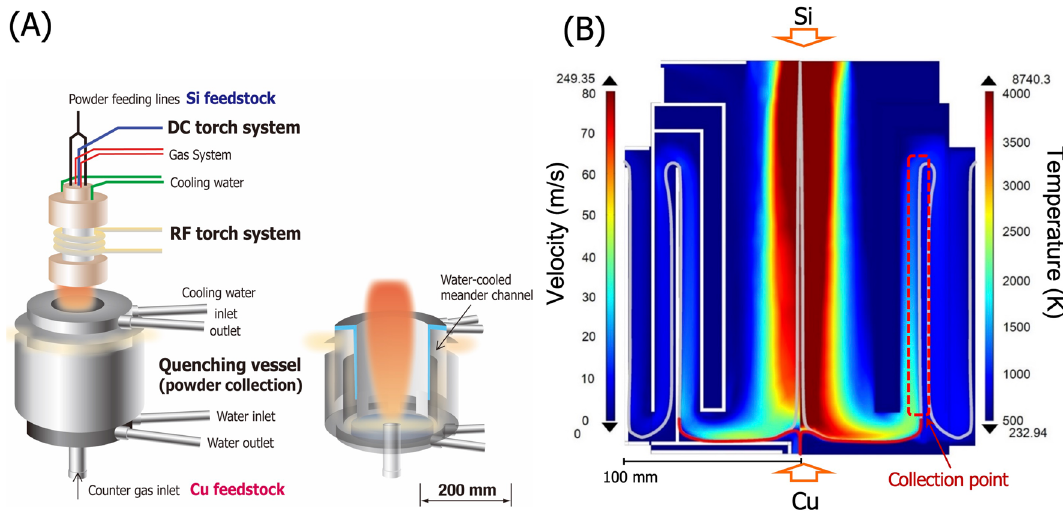
Figure 1. ( A ) Schematic illustration of the separate powder injection plasma flash evaporation (sPFE) apparatus. A hybrid plasma torch (DC and RF torches) is attached to the reaction chamber and a water-cooled gas quenching vessel is placed under the plasma torch. ( B ) Calculated plasma gas velocity and temperature distributions in the gas quenching vessel under the present sPFE condition. The detailed calculation condition can be found elsewhere 3 .